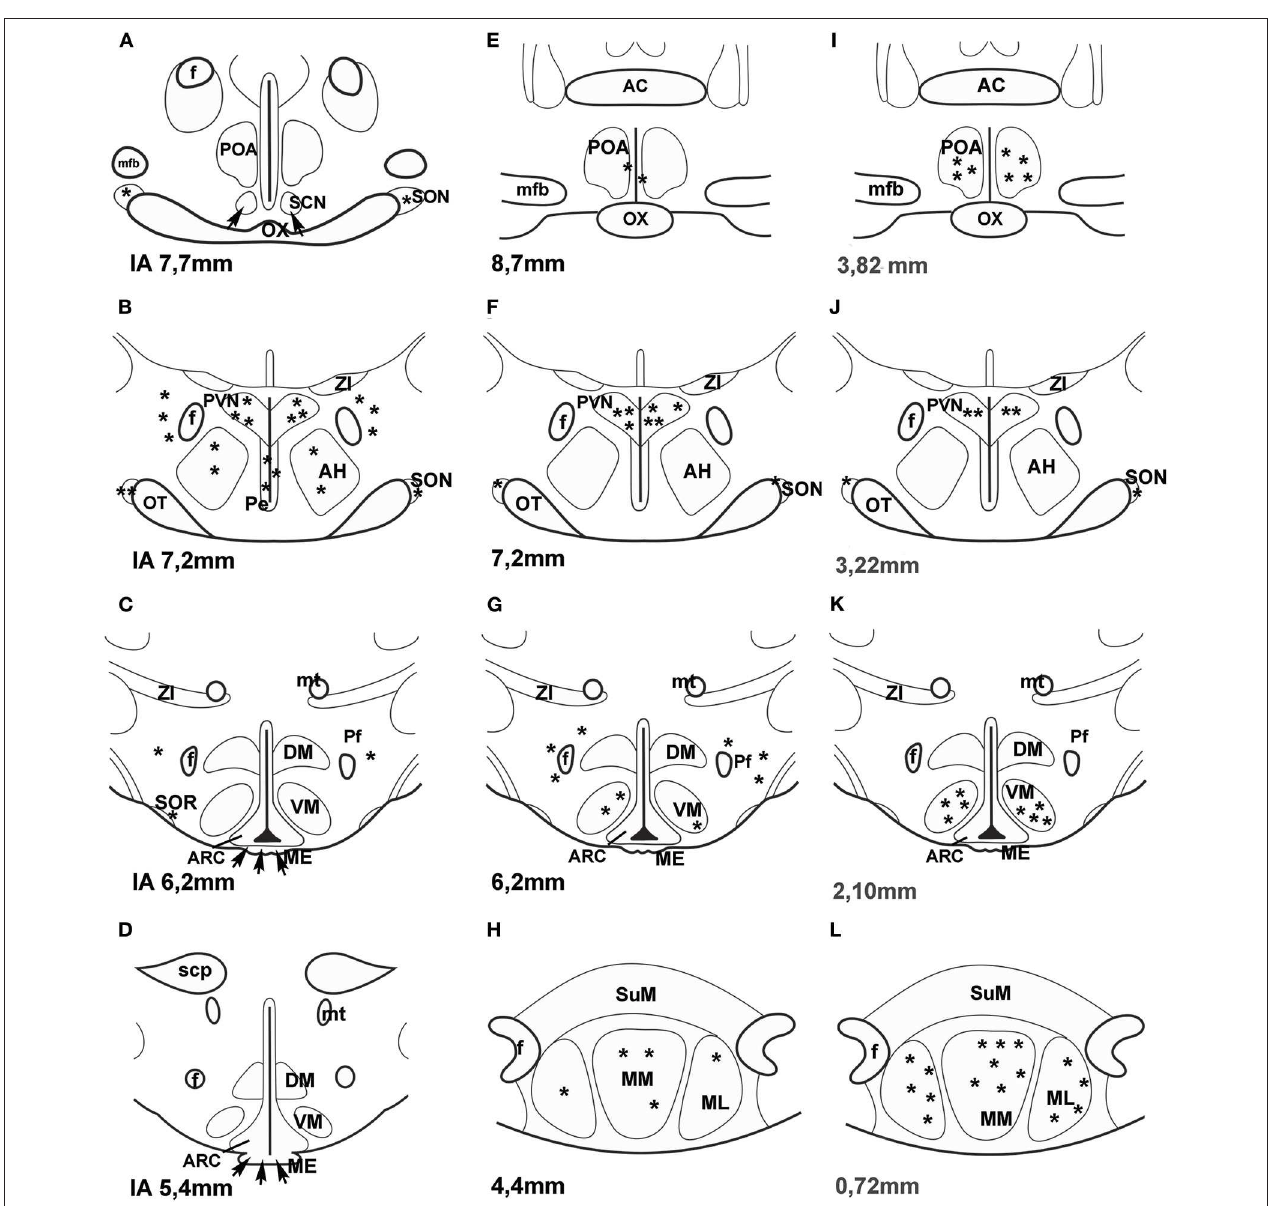
FIGURE 1 | (A–H) Distribution of PACAP-immunoreactive cells and fibers and PACAP mRNA- expressing cells in frontal sections of the rat hypothalamus according to Paxinos and Watson’s stereotaxic coordinates. (I–L) Distribution of PACAP expressing neurons in PACAP-EGFP transgenic mouse hypothalamus according to Franklin and Paxinos’ Mouse Brain in stereotaxic Coordinates. (A–D) shows PACAP immunoreactive elements in rats. Data were obtained by Köves et al. (26), Kivipelto et al. (28), and Tamada et al. (29). (E–H) shows PACAP mRNA expressing cells in rats. Data were obtained by Hannibal et al. (33); Moore and et al. (34) and Dürr et al. (45). (I–L) shows EGFP-PACAP in transgenic mice (44). Asterisks indicate cell bodies, arrows indicate fibers. AC, anterior commissure; AH, anterior hypothalamus; f, fornix; ME, median eminence; mfb, medial forebrain bundle; ML, medial mammillary nucleus, lateral part, MM, medial mammillary nucleus; mt, mammillothalamic tract, OT, optic tract; OX, optic chiasm; Pe, periventricular nucleus; Pf, perifornical nucleus; POA, preoptic area; PVN, paraventricular nucleus; SCN, suprachiasmatic nucleus; scp, superior cerebellar peduncle; SON, supraoptic nucleus; SOR, retrochiasmatic portion of SON; SuM, supramammillary nucleus; ZI, zona incerta. Reproduced and modified from Köves et al. (46). Permission to reuse was obtained from Springer Nature. Permission # 4762591108219 .